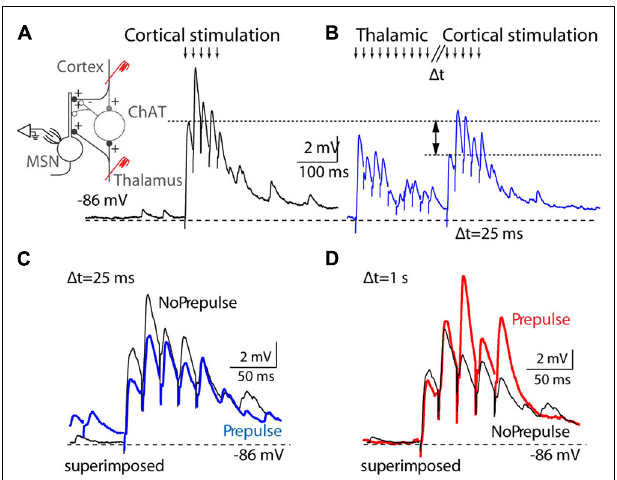
FIGURE 5 |Thalamostriatal projections gate corticostriatal inputs in mouse slices. (A) Left, diagram of the experimental preparation: medium spiny neuron (MSN) recorded in the striatum while corticostriatal projections are activated, with or without preceding stimulation of thalamostriatal projections. Right, activation (downward arrows) of corticostriatal input evokes a train of EPSPs in a MSN cell. (B) Corticostriatal EPSPs are reduced when thalamostriatal stimulation precedes the corticostriatal stimulation by 25 ms. (C) Overlay of corticostriatal EPSPs before and after (blue) thalamostriatal activation to illustrate the changes in amplitude. (D) Overlay of corticostriatal EPSPs before and after (red) thalamostriatal activation, but with a long delay (1 s) between the thalamostriatal and corticostriatal activation. [Reprinted from (Ding etal., 2010), with permission from